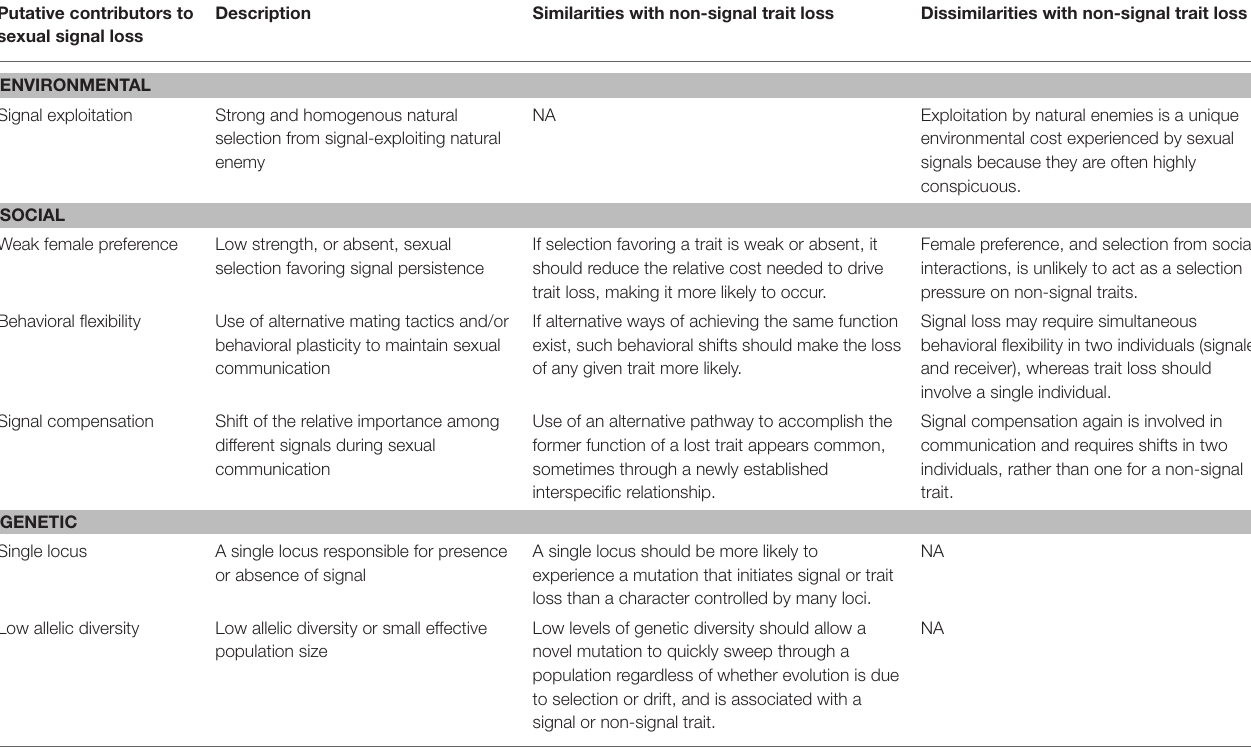
TABLE 1 | Summary of key contributors to sexual signal loss and discussion of their general applicability to evolutionary loss of non-signal